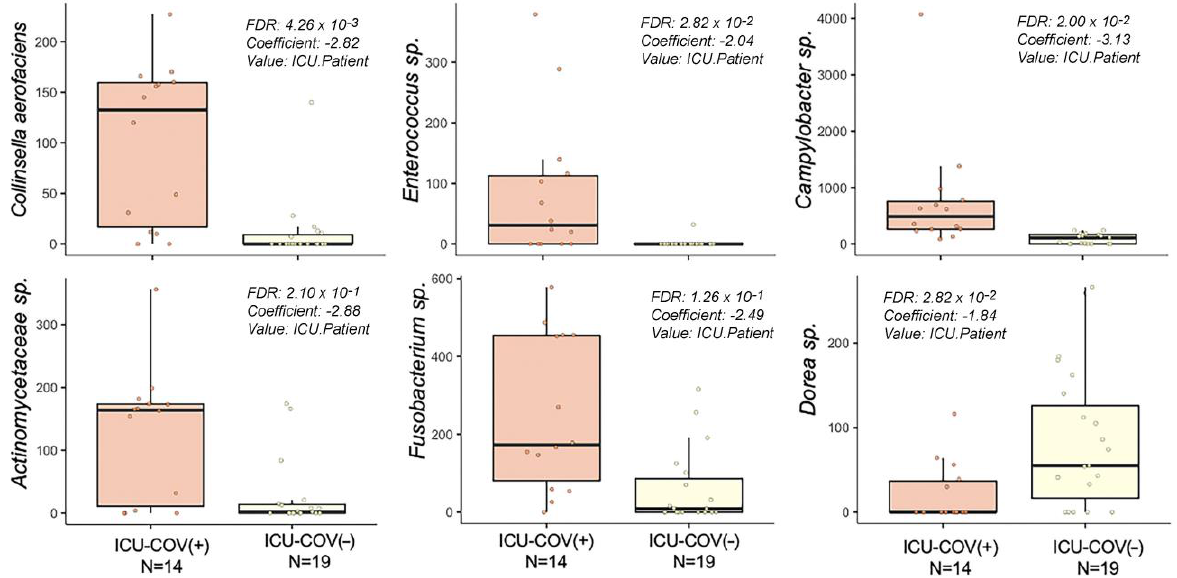
Figure 2. Gut bacterial taxa associated with ICU-COV(+) patients and their predictive value. Comparison of the gut microbiome sequence data between ICU-COV(+) and ICU-COV( − ) patients who did not receive antibiotics or corticosteroids before ICU admission using MaAsLin2 identified six bacterial species (FDR < 0.22). ICU = intensive care unit; COV( − ) = COVID-19-negative; COV(+) = COVID-19-positive; RS = rectal swab; TA = tracheal aspirate.